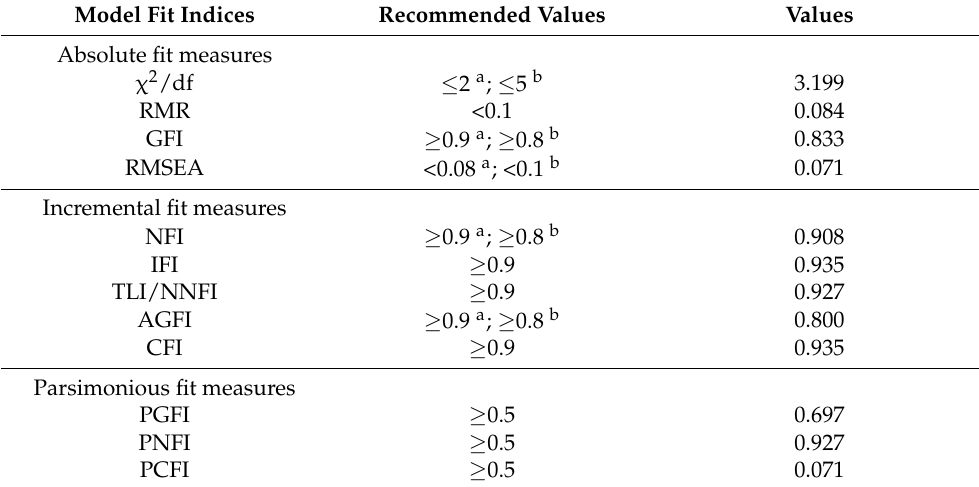
Table 2. Results of model fit indices for measurement model. (N =